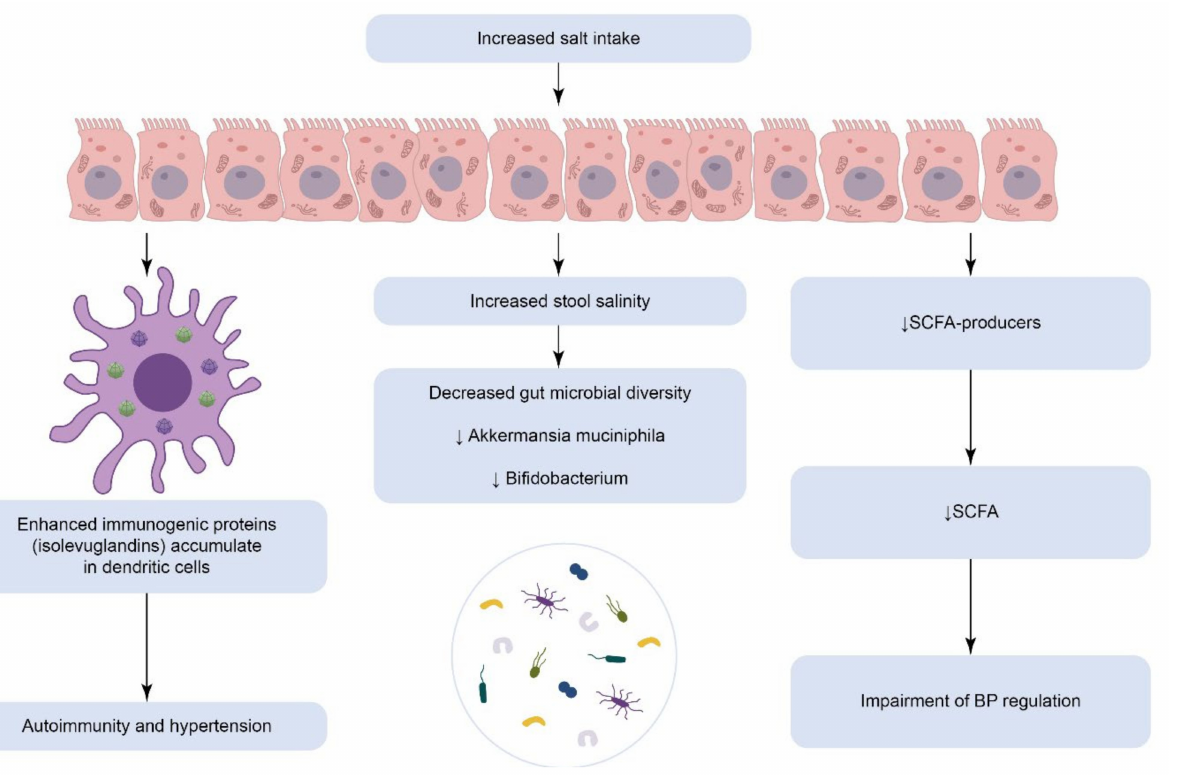
Figure 1. The impact of excess salt intake on gut microbiota composition and arterial hypertension development. BP: Blood Pressure, SCFA: Short Chain Fatty